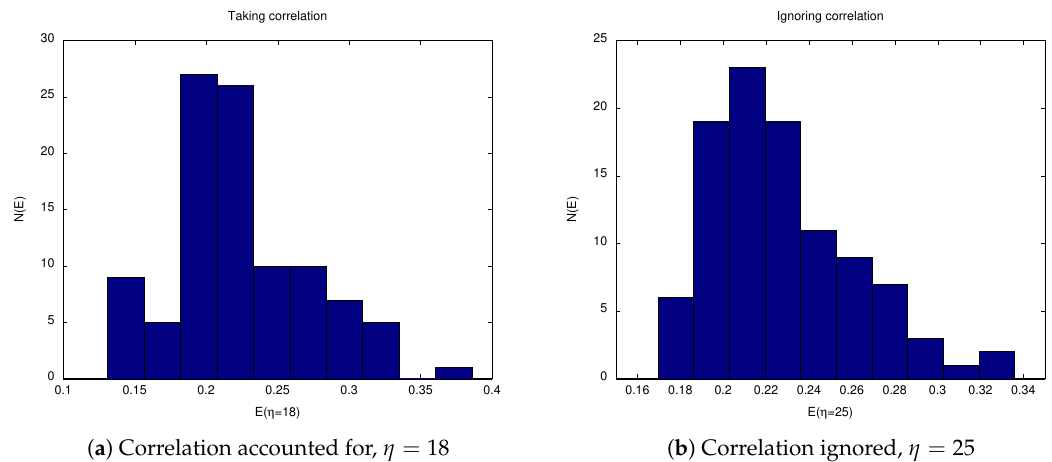
Figure 5. Histograms of the root mean squared error E from 100 observation sequences at the optimal value of η in both scenarios when the error’s correlation is taken into account or